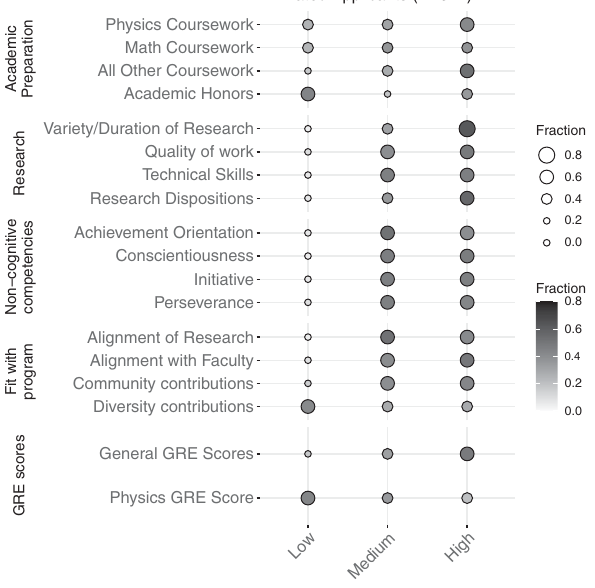
FIG. 1. Faculty ratings of domestic applicants on 18